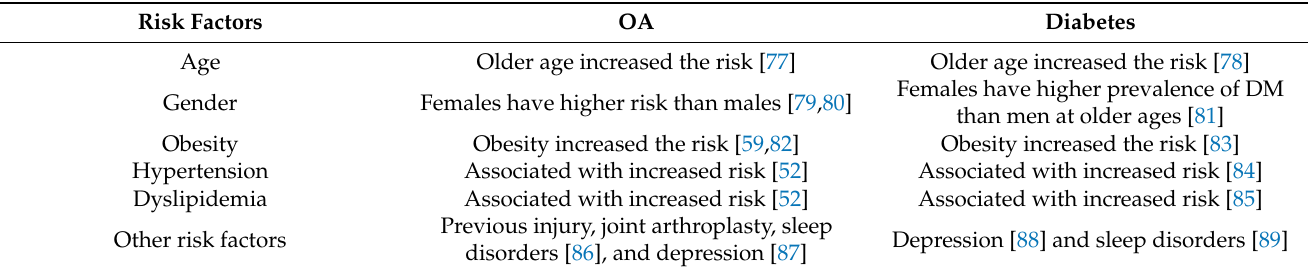
Table 2. Summary of shared risk factors for OA and